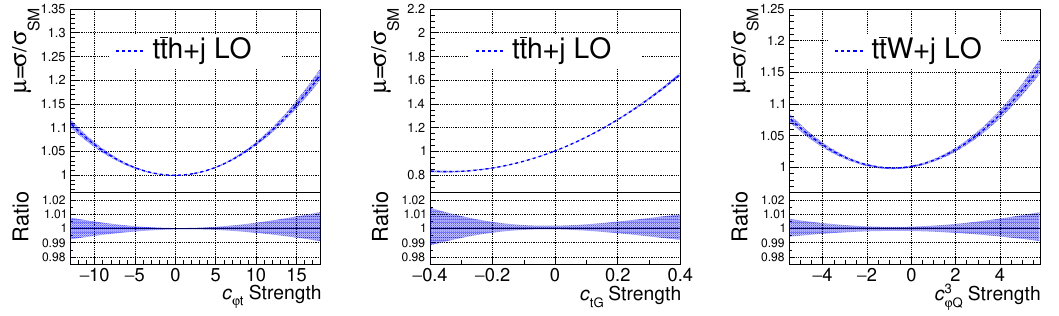
Figure 11 . Systematic uncertainties on the inclusive t¯th cross sections for c ϕ t and c t G , and on the inclusive t¯tW cross section for c 3 . The cross sections are normalized to the SM, as discussed in ϕQ the text. Additionally, the range for each Wilson coefficient is taken from the marginalized limits presented in ref.